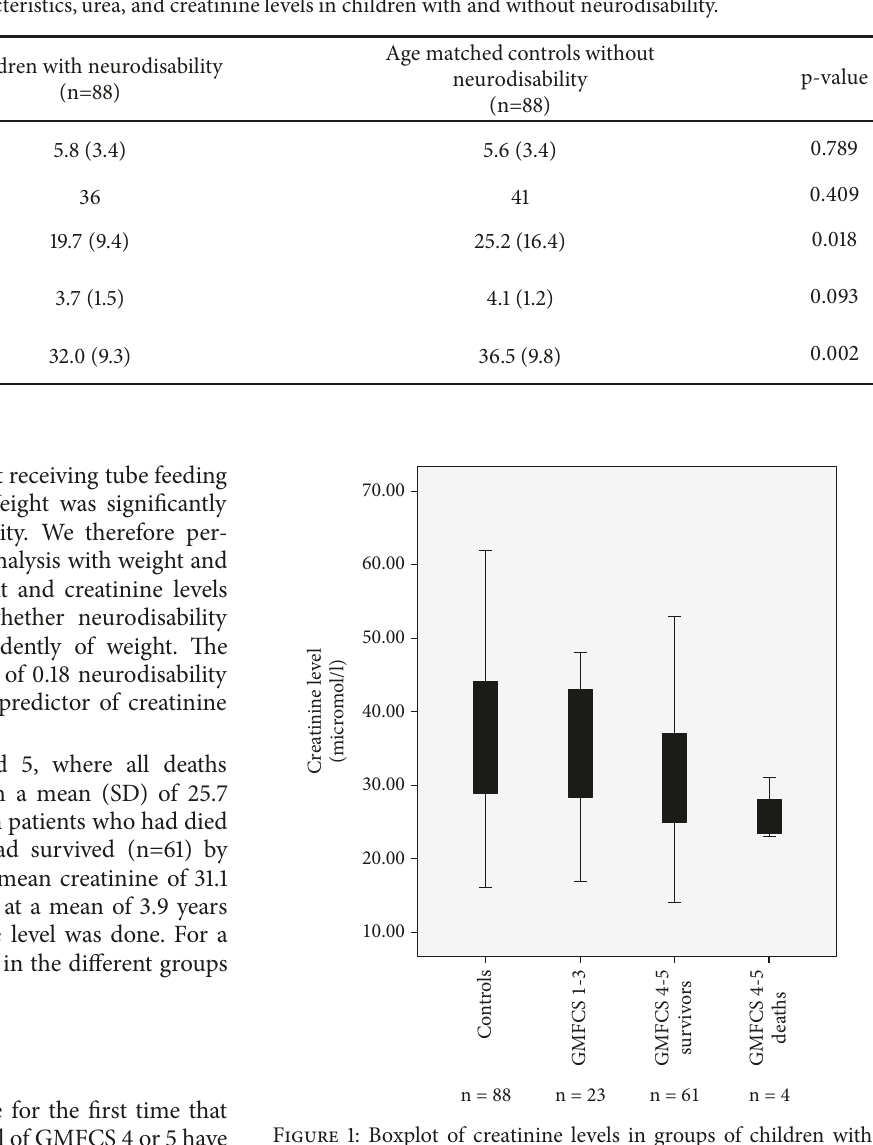
Figure 1: Boxplot of creatinine levels in groups of children with neurodisability with Gross Motor Function Classification System (GMFCS) 1 to 3, GMFCS 4 or 5 who survived, GMFCS 4 or 5 who died, and controls without neurodisability. Lower and higher end of the whiskers represent minimum and maximum and lower and higher margin of the box first and third quartiles,